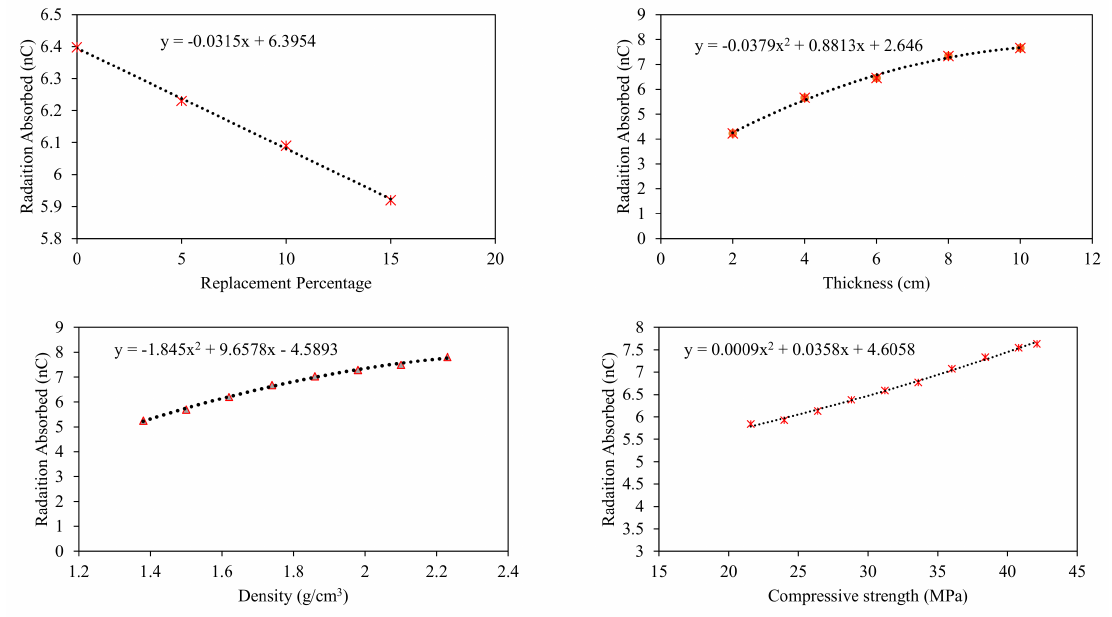
Figure 9. Parametric analysis of ANN model for Type 2 bricks.